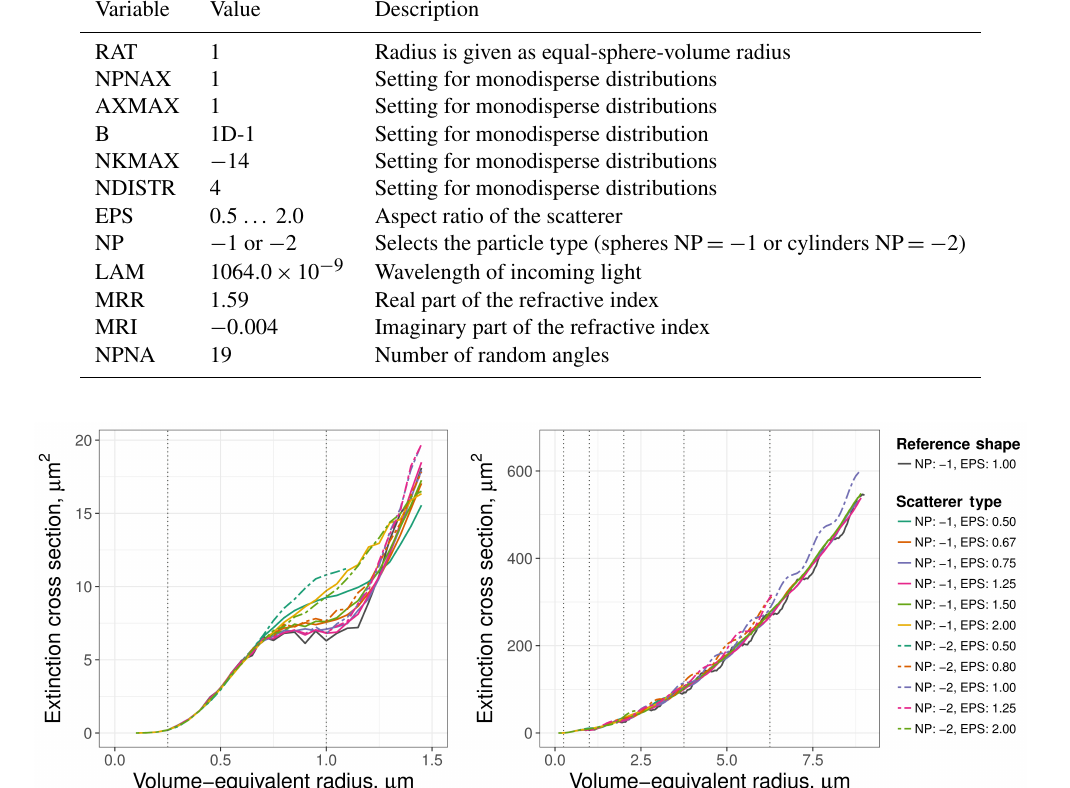
Figure 7. Extinction cross section spectrum for the reference particle (sphere, dark grey line), six types of ellipsoids (EPS = 1, solid lines), and five types of cylinders (EPS = − 2, dashed lines) against the particles’ equal-volume radius R p at λ = 1064nm. Vertical dotted lines indicate the size margins of each class. The particle shape effect is negligible for particles with a radius much smaller than the wavelength. Particles which have a radius equal to the wavelength show differences of the extinction cross section depending on their shape. With larger particle sizes, the particle shape effect is negligible for the considered shapes and aspect